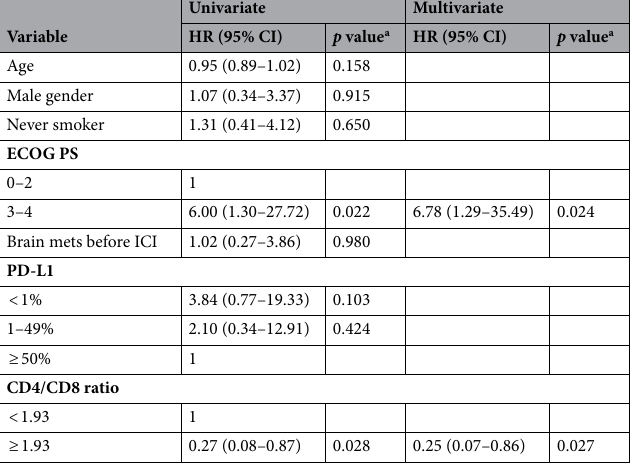
Table 4. Univariate and multivariate analyses of risk factors for progression free survival. ECOG PS, Eastern Cooperative Oncology Group performance status; mets, metastasis; ICI, immune checkpoint inhibitor; HR, hazard ratio; CI, confidence interval. a Probability value by Cox regression